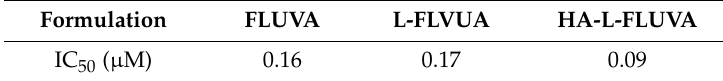
Figure 3. Anti-proliferative e ff ect of fluvastatin (FLUVA) formulations on BCSCs, as assessed via a sphere-forming assay. Table 2. The half maximal inhibitory concentration (IC 50 ) values of the sphere-forming ability (%) of FLUVA, liposomal FLUVA (L-FLVUA), and hyaluronan-conjugated FLUVA-encapsulating liposomes